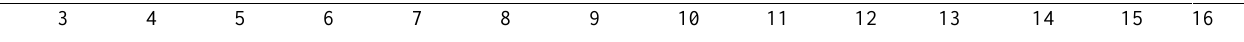
Table 1: Means, standard divisions, and intercorrelations among the key variables of the